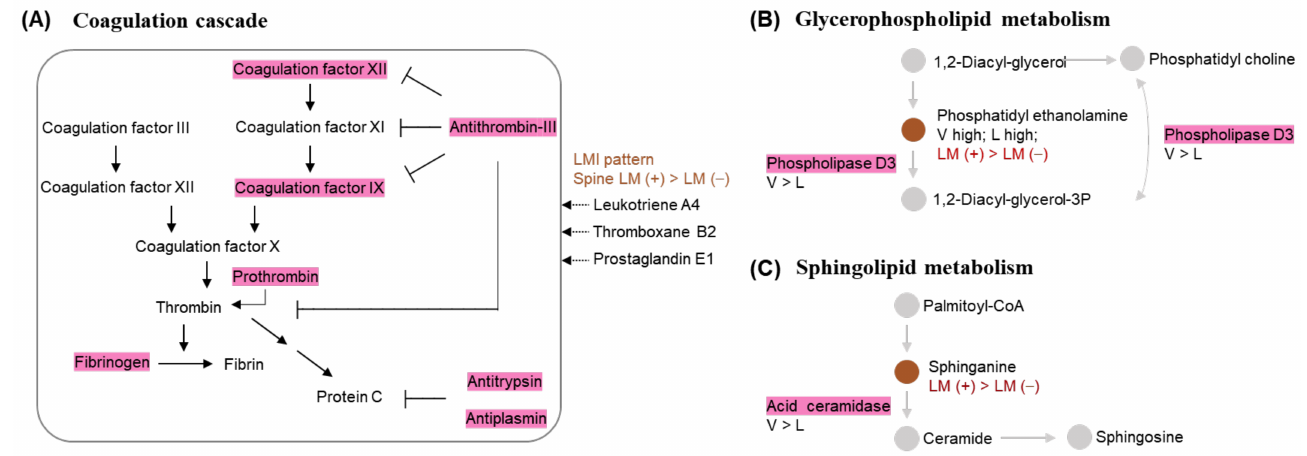
Figure 8. Metabolite–protein interaction network from LM CSF. Shaded proteins are relatively abundant in spinal LM (+) samples over LM ( − ) samples (pink) or in the ventricular CSF over lumbar CSF (grey). ( A ) Proinflammatory cytokines were abundant in discriminative LMIs of spinal LM (+) samples and coagulation cascade proteins were relatively abundant in the inhibition of coagulation activation. ( B , C ) Enzymes with relatively low expression levels in lumbar CSF were connected to discriminative LMIs in spinal LM (+)